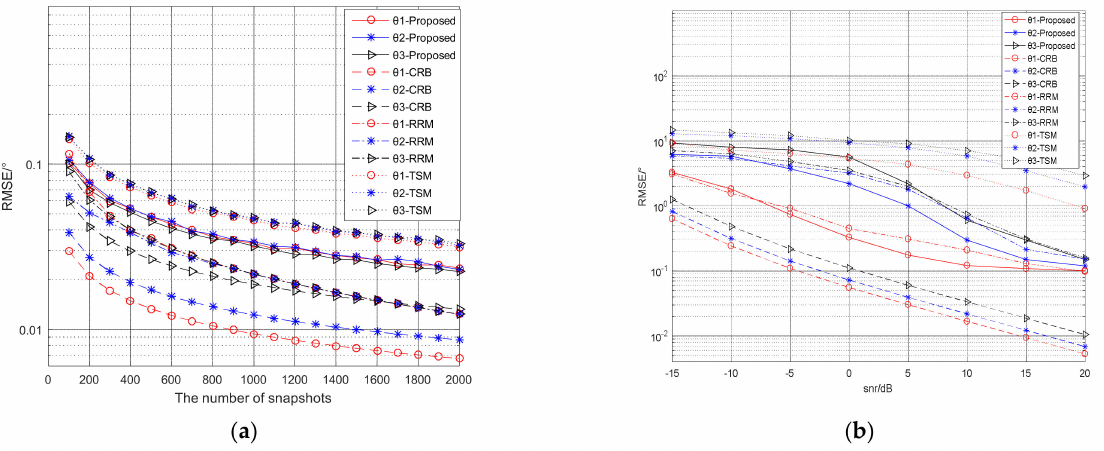
Figure 6. ( a ) The relationship between NS and the RMSE of the DOAs estimation; ( b ) The relationship between the SNR and the RMSE of the DOAs estimation.